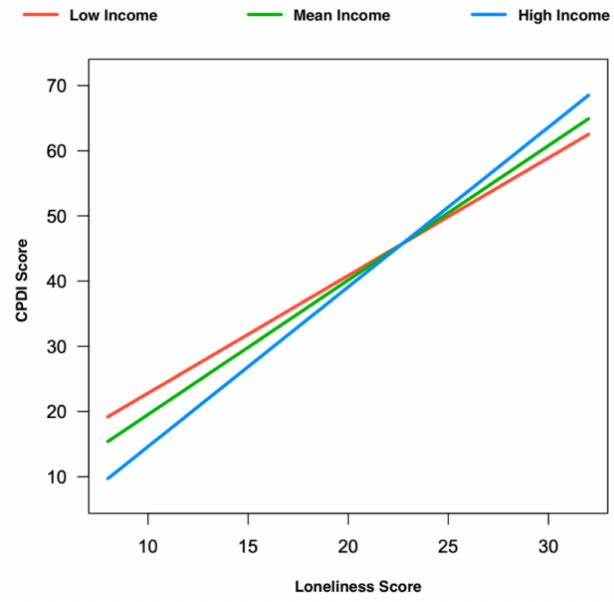
Figure 2. The effect of loneliness and income on psychological distress response in Germany during COVID-19 pandemic. The CPDI score, capturing psychological distress among general populations, is displayed as a function of loneliness (ULS-8 score) for high income in blue versus low income in red. Each participant’s self-reported annual net income was ranked higher versus lower than the median ( n = 1193/1068: 442 subjects’ data in the median (category of € 15.000– € 24.999) were